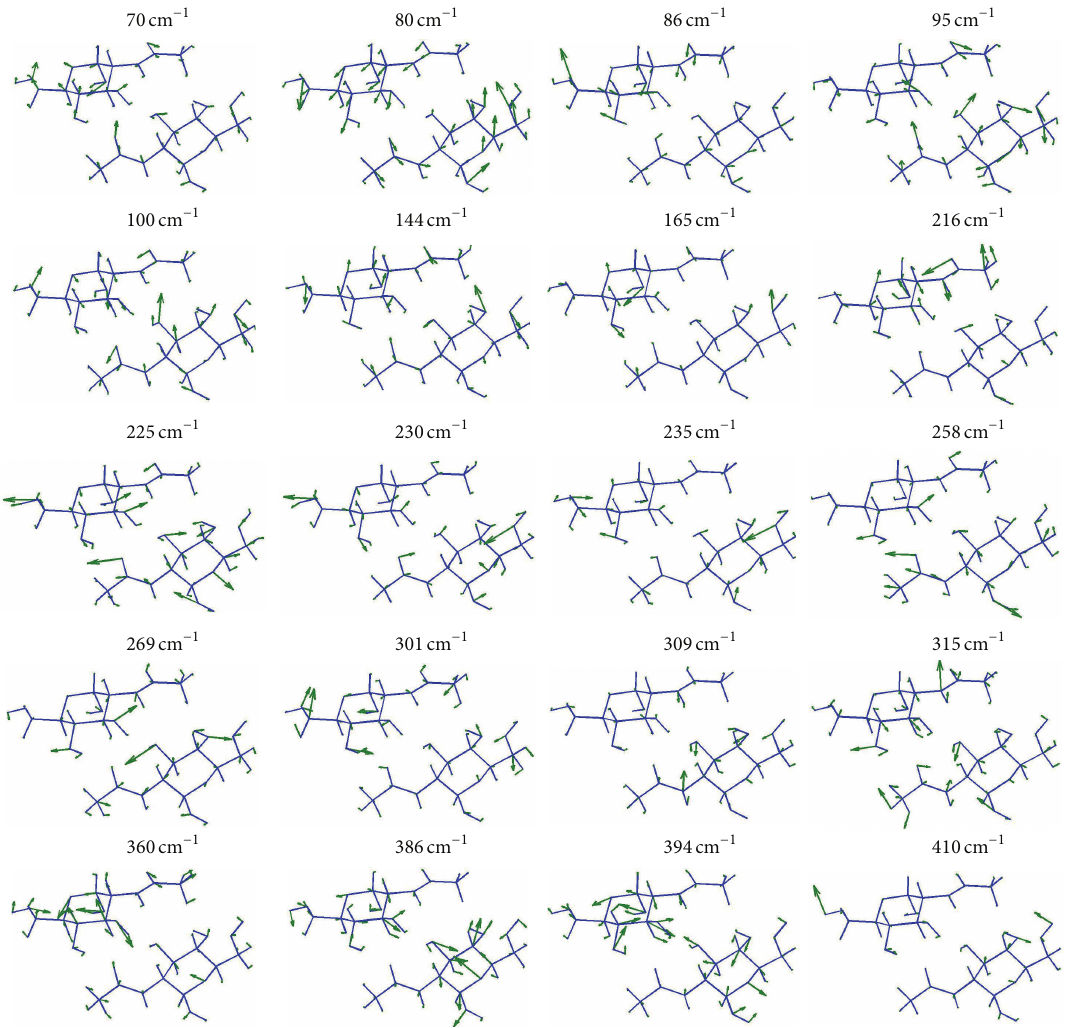
Figure 7: Mass-scaled normal modes of the frequencies in the far infrared spectrum of N